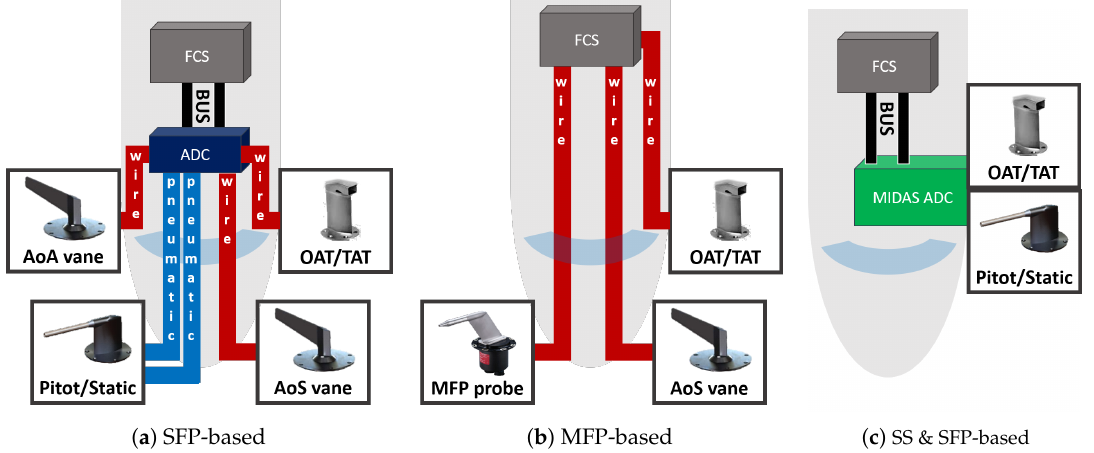
Figure 1. Top view of three realistic simplex air data system (ADS) architectures able to provide a complete set of air